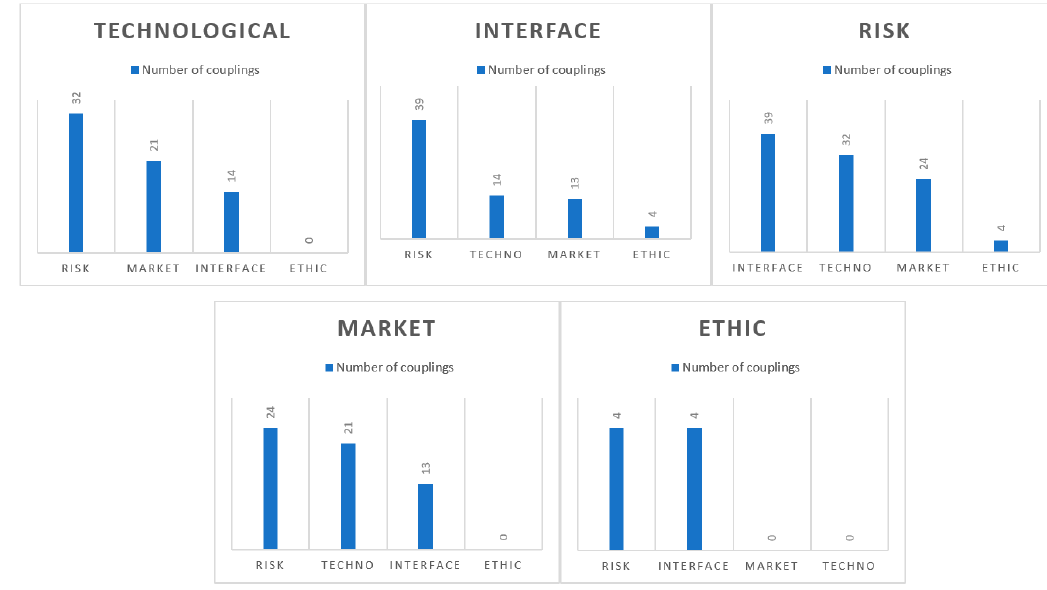
Figure 4. Two-way couplings between frames.